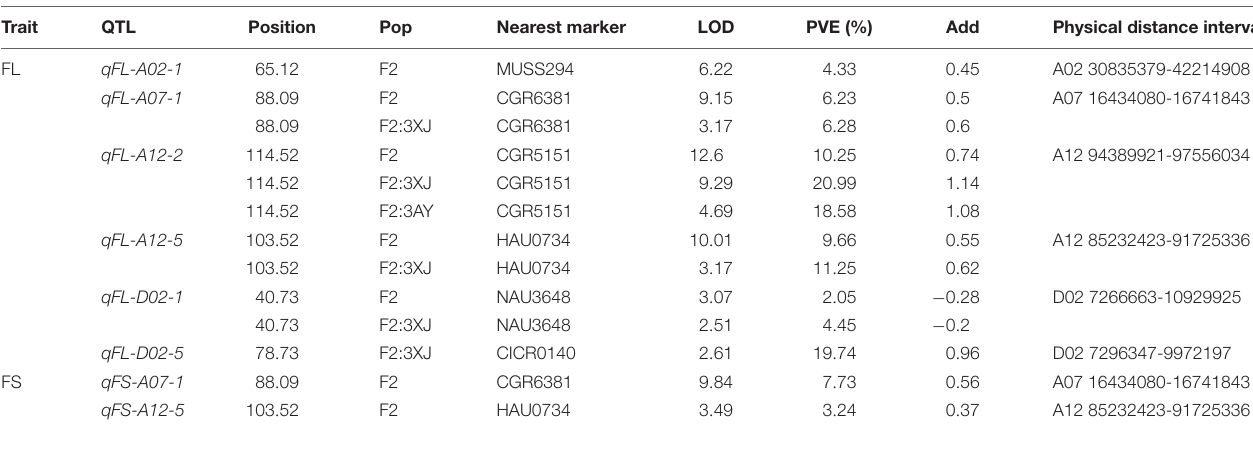
FIGURE 1 | The Gossypium barbadense chromosomal segments carried by the MBI7747 line. Red represents heterozygous fragments and green represents homozygous fragments. TABLE 4 | Fiber quality-related QTLs detected via QTL